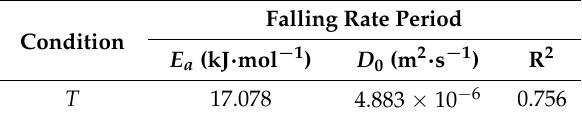
Table 11. Activation energy of lignite at different temperatures during hot-air drying. Falling Rate Condition